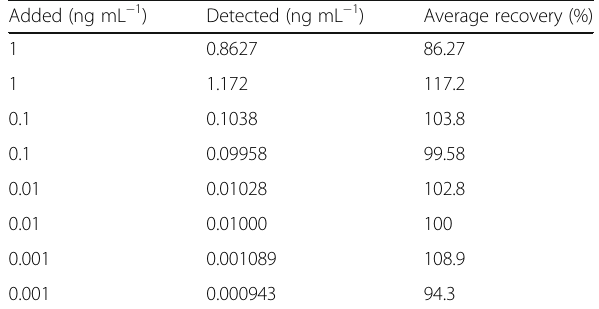
Table 2 Recovery tests for MMP-7 in human serum